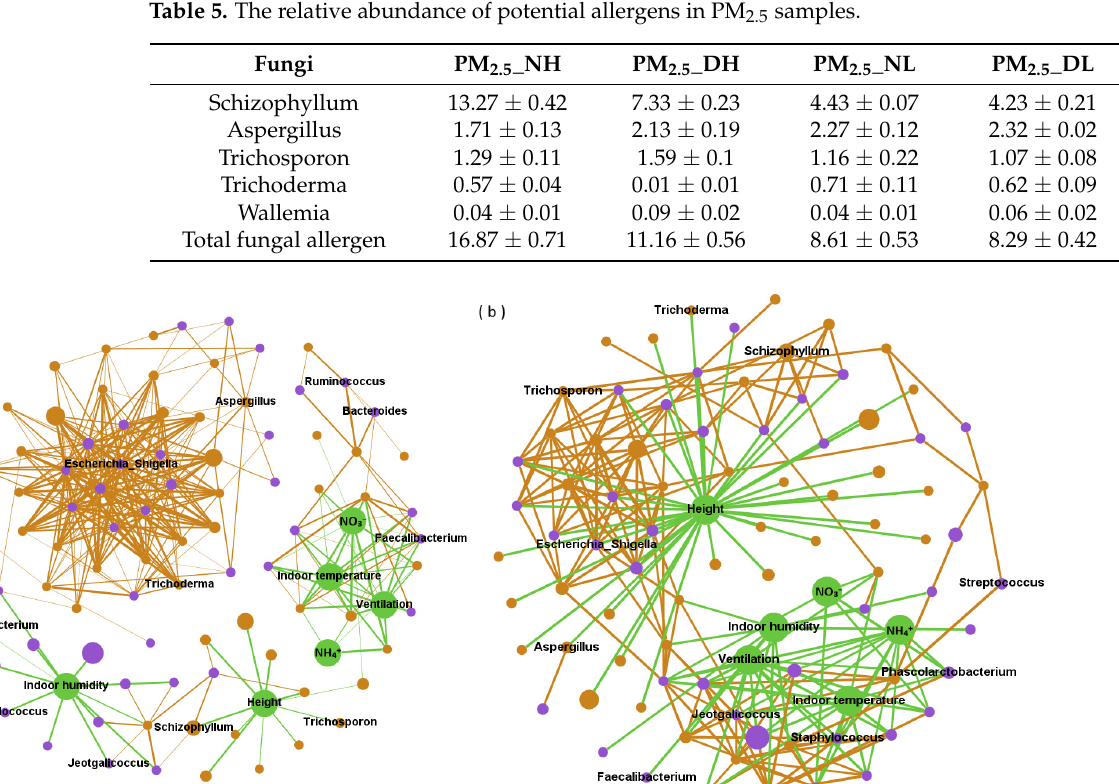
Table 5. The relative abundance of potential allergens in PM 2.5 samples.